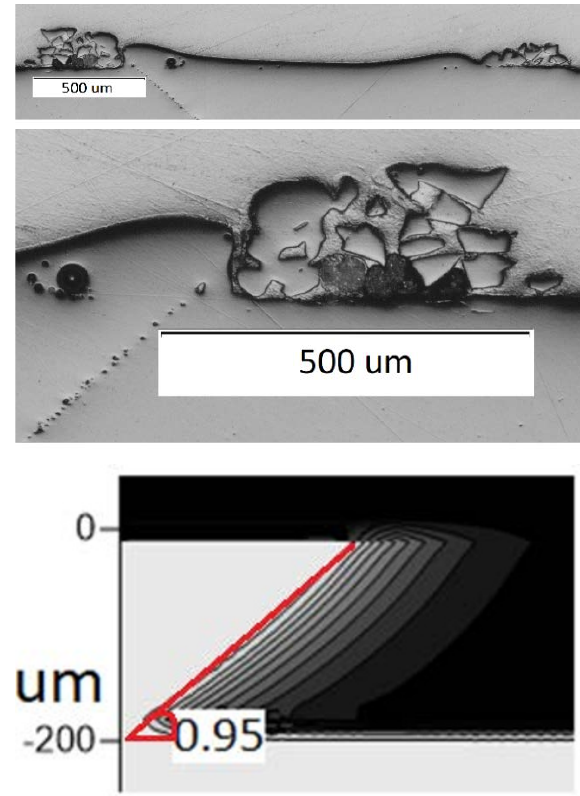
Fig. 9. Cross section of tracks made at 1 mm/s 30 W(on the top) same zoomed track (in the middle) and his modelling (on the bottom). The red lines show the angle between the substrate and the consolidation border.